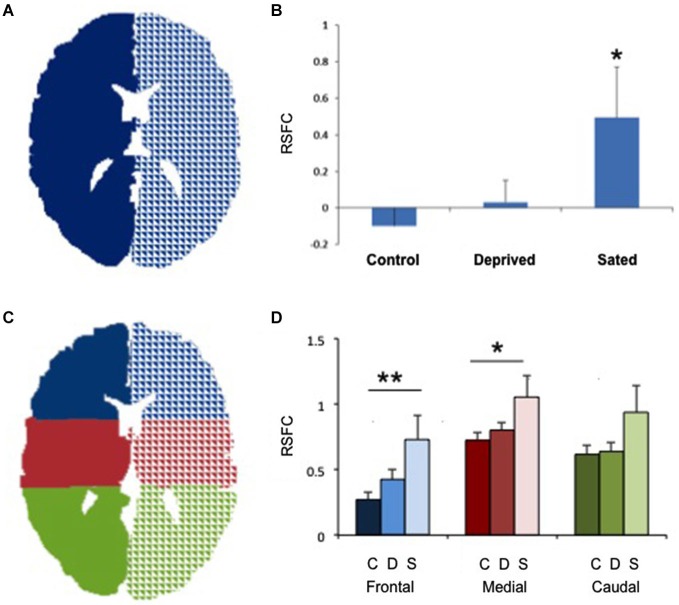
Increased interhemispheric connectivity in sated smokers. (A) The two seeds used to study right/left connectivity. Only one central section is shown. (B) Interhemispheric resting state functional connectivity (RSFC) in non-smokers, deprived smokers and sated smokers. *p < 0.02 vs. controls. (C) The 6 seeds used for frontal, medial and caudal interhemispheric connectivity assessment. Only one central section is shown. (D) Interhemispheric resting state functional connectivity (RSFC) in non-smokers (C, darker bars), deprived smokers (A, medium bars) and sated smokers (S, lighter bars) in frontal, medial, and caudal sections. **p < 0.005, *p < 0.05 vs. controls in the same area.